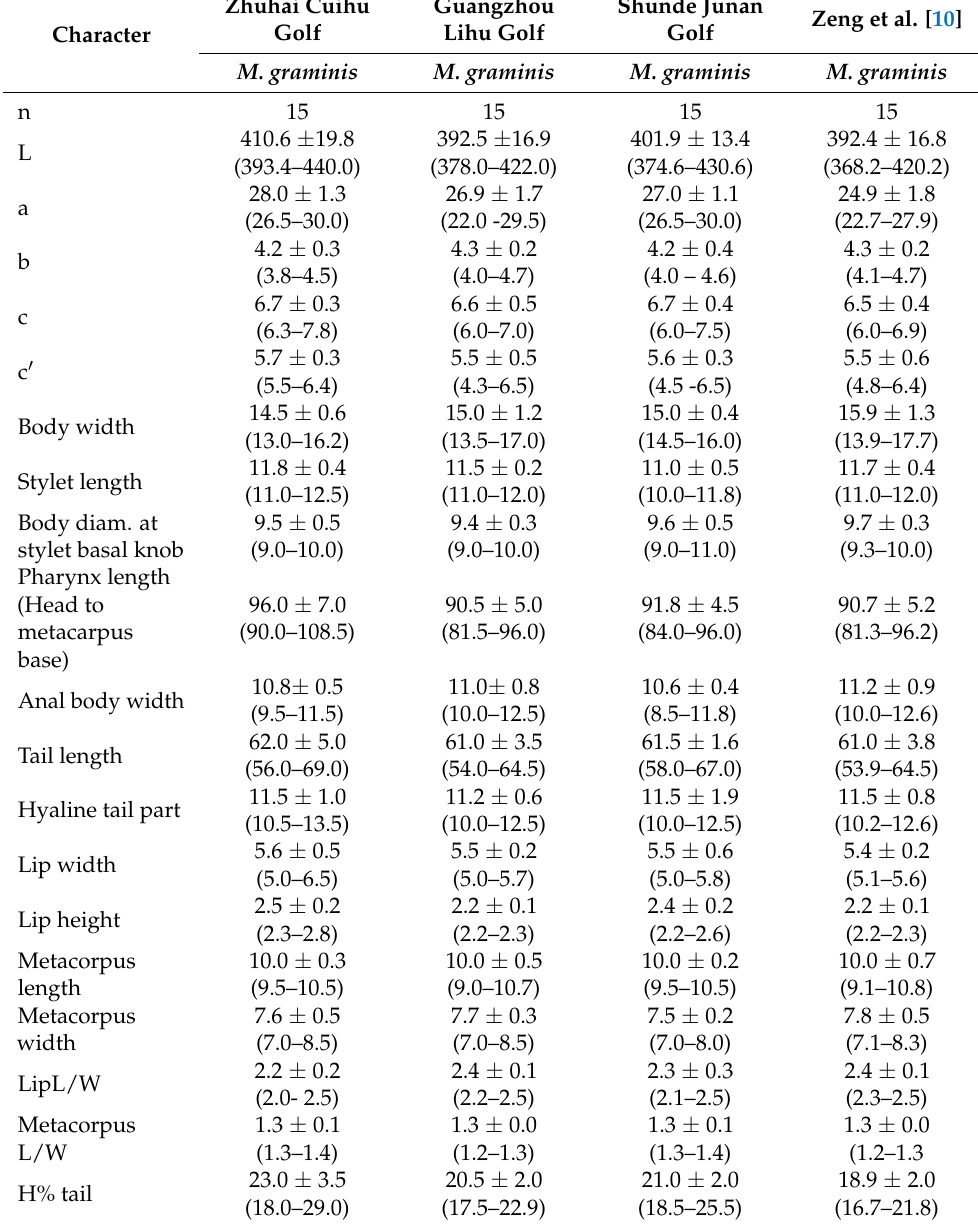
Table 6. Morphometrics of second-stage juveniles of Meloidogyne graminis populations mounted in formalin–glycerin in this study compared to those reported by Zeng et al. [10]. All measurements in µ m and in the format: mean ± s.d.